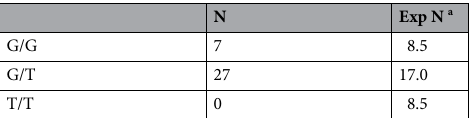
Table 6. Genotypes of healthy hatched embryos and expanded blastocytes from mating between heterozygotes with AC_000174.1:g.74743512G>T. a The expected number of embryos were estimated from mating between